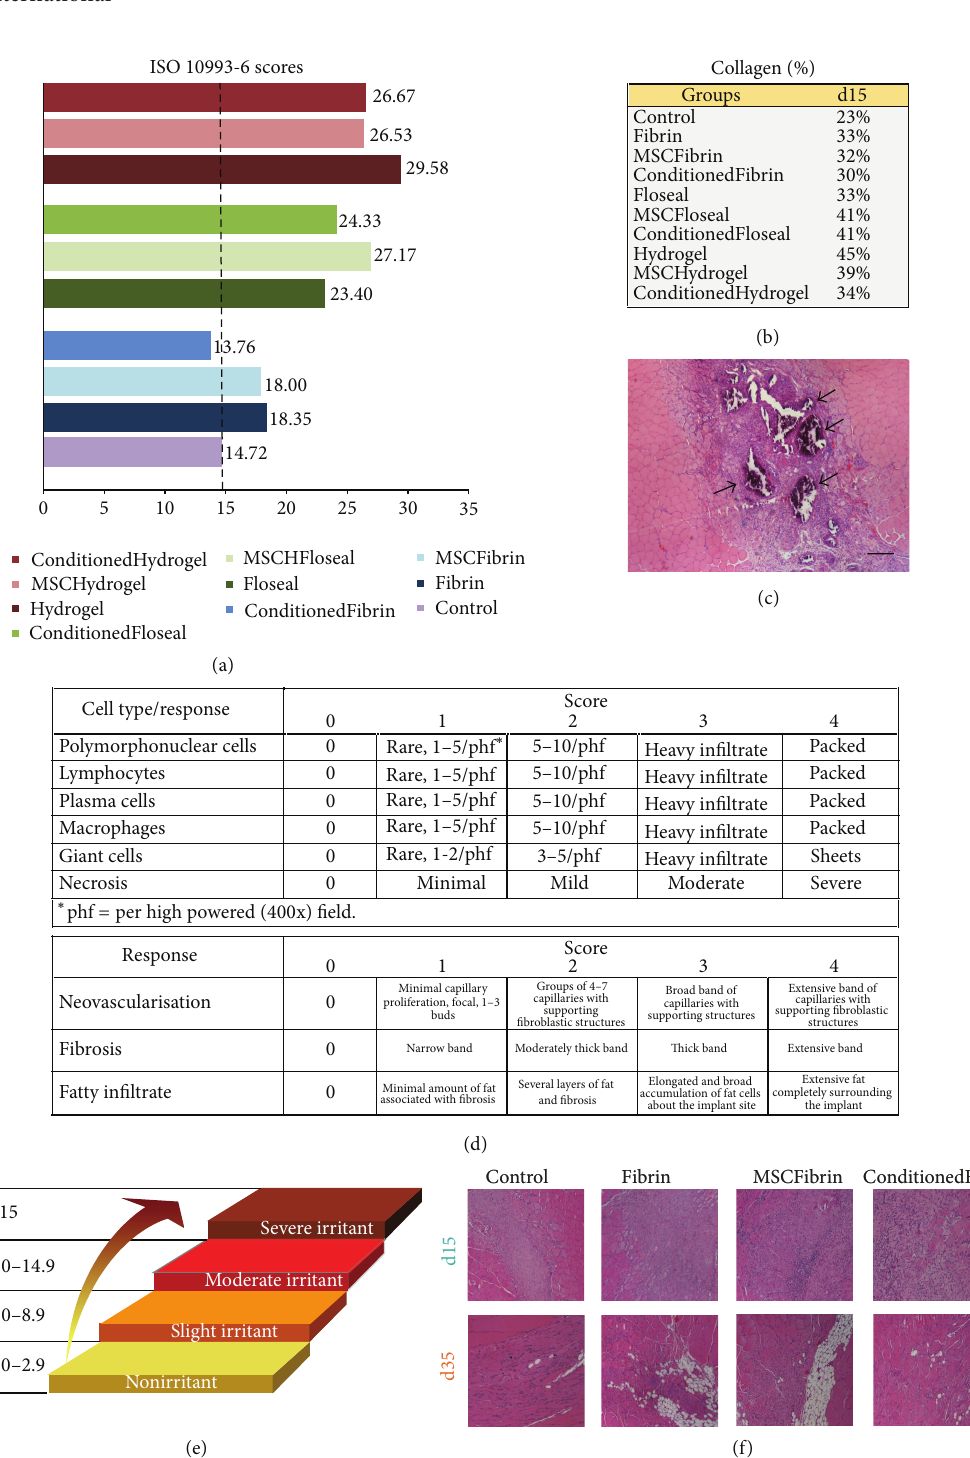
Figure 3: ISO 10993-6 scoring for the groups tested at d15. The Control group obtained a score of 14.72. The tested implants can be considered as slight, moderate, severe, and nonirritant depending on the score obtained in comparison to the Control group (a). Collagen fractions for the groups tested at d15 (b). Histological appearance (H&E staining) of a tibialis anterior (TA) muscle with exuberant calcification (arrows) after Floseal implantation (magnification: 40x). Scale bar: 50 𝜇 m (c). Scoring system used for biological evaluation of degradable materials taking into account inflammation, neovascularization, fibrosis, and fatty infiltrate-ISO 10993-6 Annex E (d). International Standard classification of the biomaterials attributed by the results obtained through the previous scoring system: the average subtotal inflammation score is multiplied by 2 and added to the average neovascularization, fibrosis, and fatty infiltrate subtotal score. The final score for the tested biomaterial is the value obtained above (or below) the Control score (e). Histological appearance (H&E staining) from Control, Fibrin, MSCFibrin, and ConditionedFibrin TA muscles at d15 and d35 for the assessment of inflammatory status